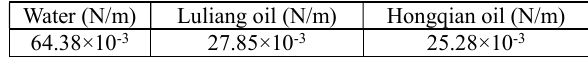
Table 3. Experimental media surface tension data